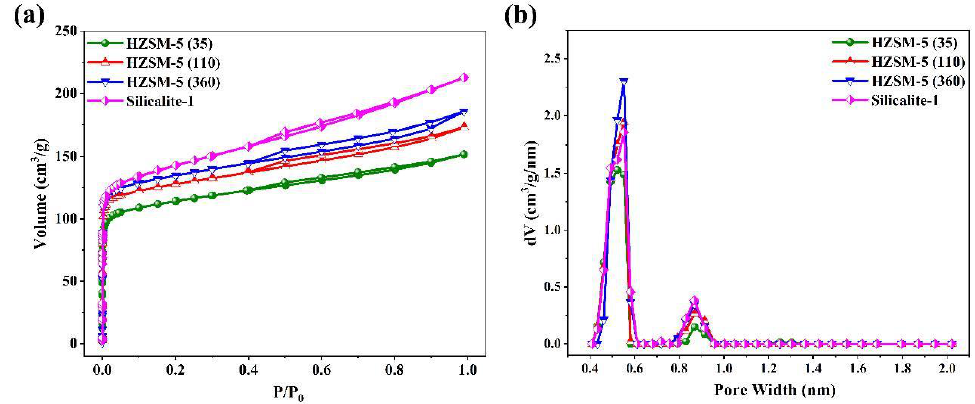
Figure 4. ( a ) Ar adsorption-desorption isotherms of all samples. ( b ) Pore size distribution of all samples. Table 1. Textural properties of MFI zeolites with different Si/Al ratios.